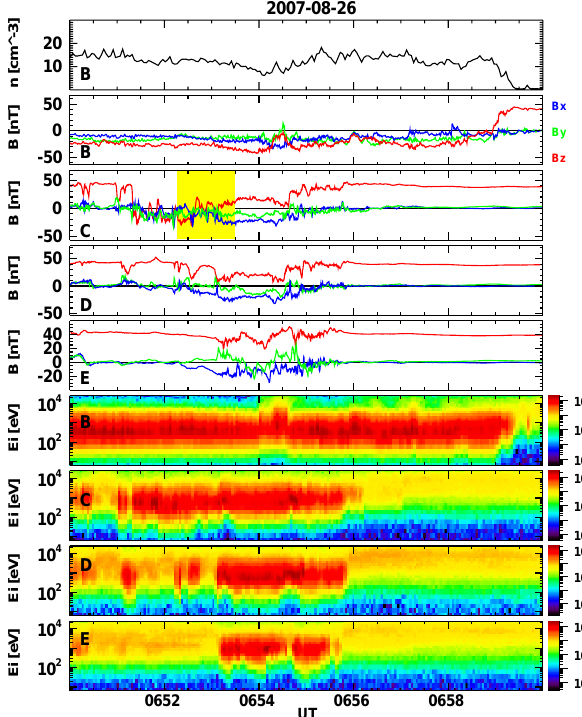
Fig. 12. Overview of Event 4. The same description of the panels as in Fig. 5. The yellow area again marks an interval of the discussed change of the B Z magnetosheath magnetic field